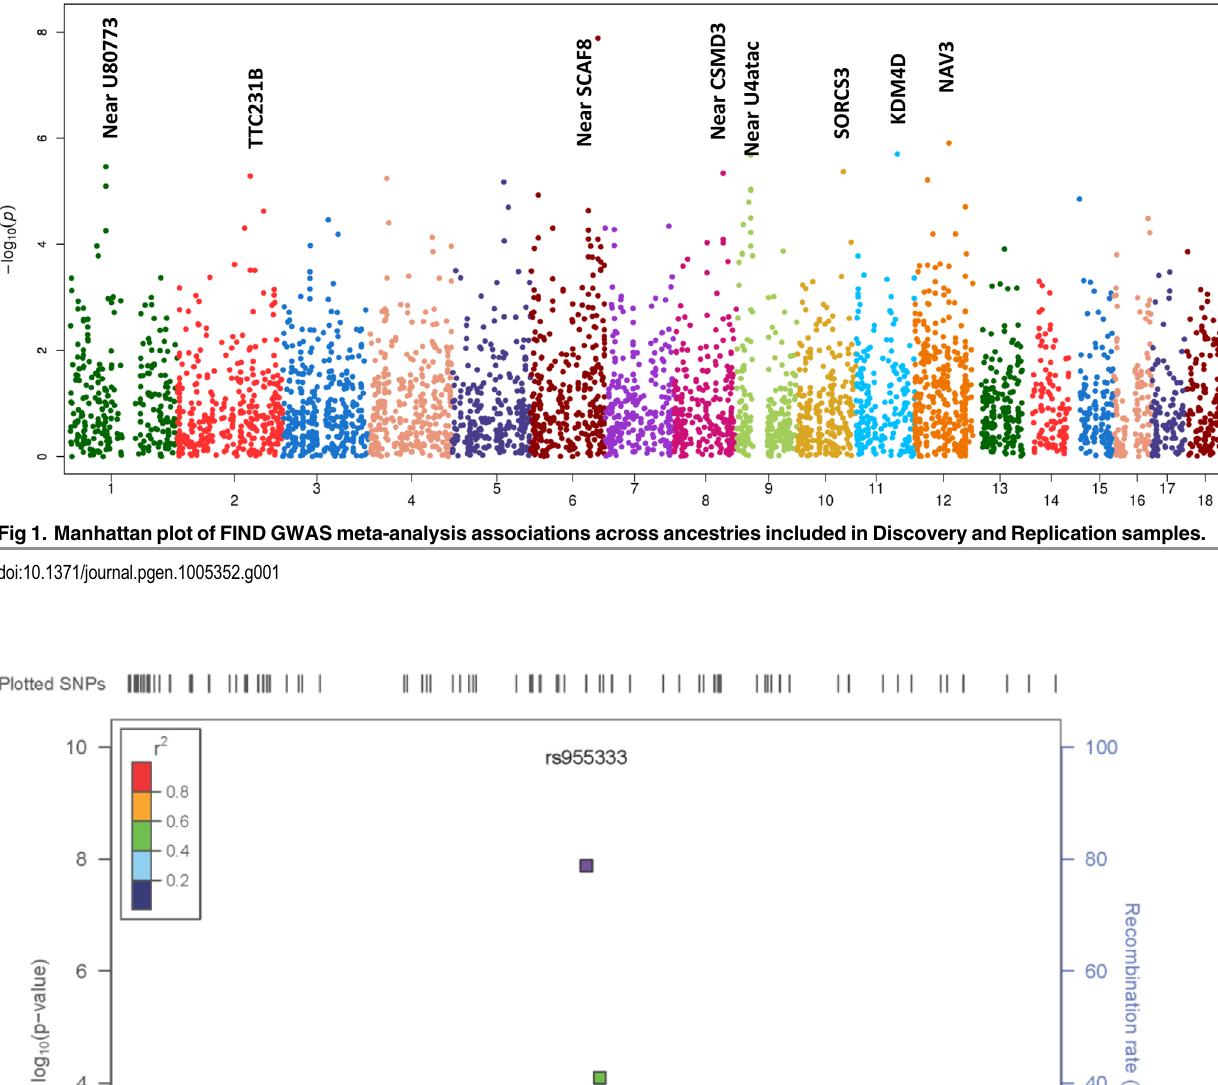
PLOS Genetics | DOI:10.1371/journal.pgen.1005352 August 25,